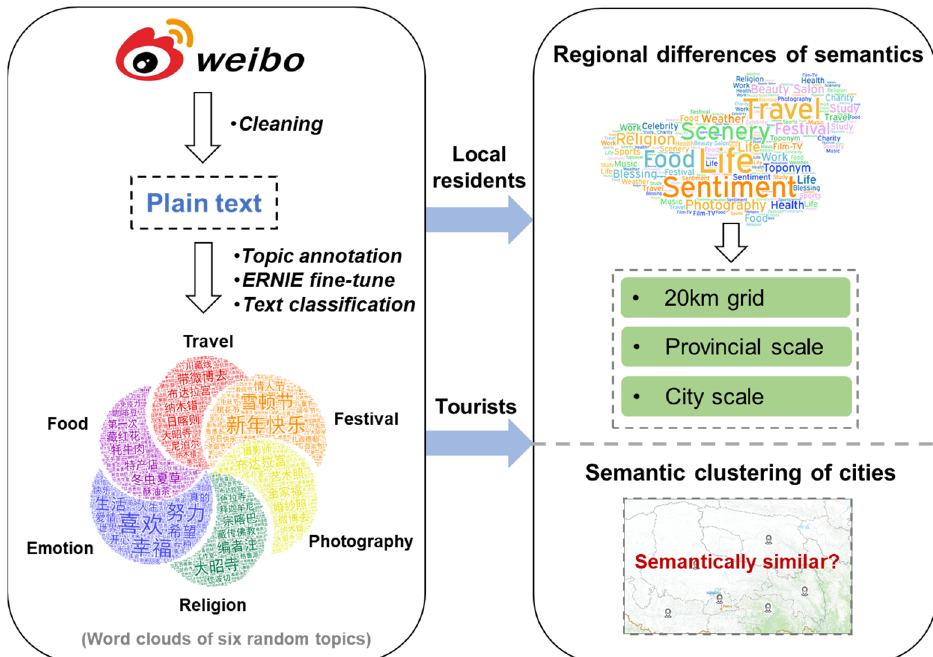
Figure 2. Schematic of the research framework employed in this study.